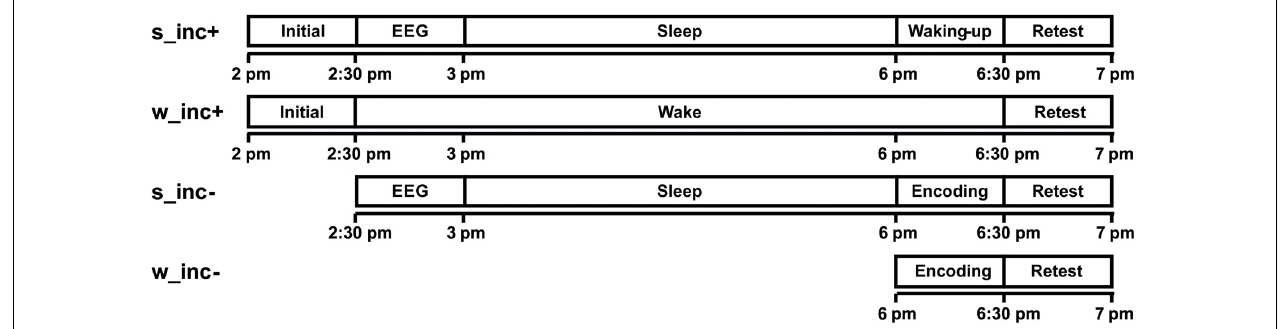
FIGURE 2 | Study design. All subjects stayed in the laboratory from 2 pm to 7 pm. The two experimental groups sleep incubation (s_inc+) and wake incubation (w_inc+) experienced a 3-h incubation period between initial encoding and retest. Both control groups (s_inc- and w_inc-) did not experience an incubation period, but the sleep no incubation group (s_inc–) slept for 3 h before encoding and retest. EEG: application of EEG